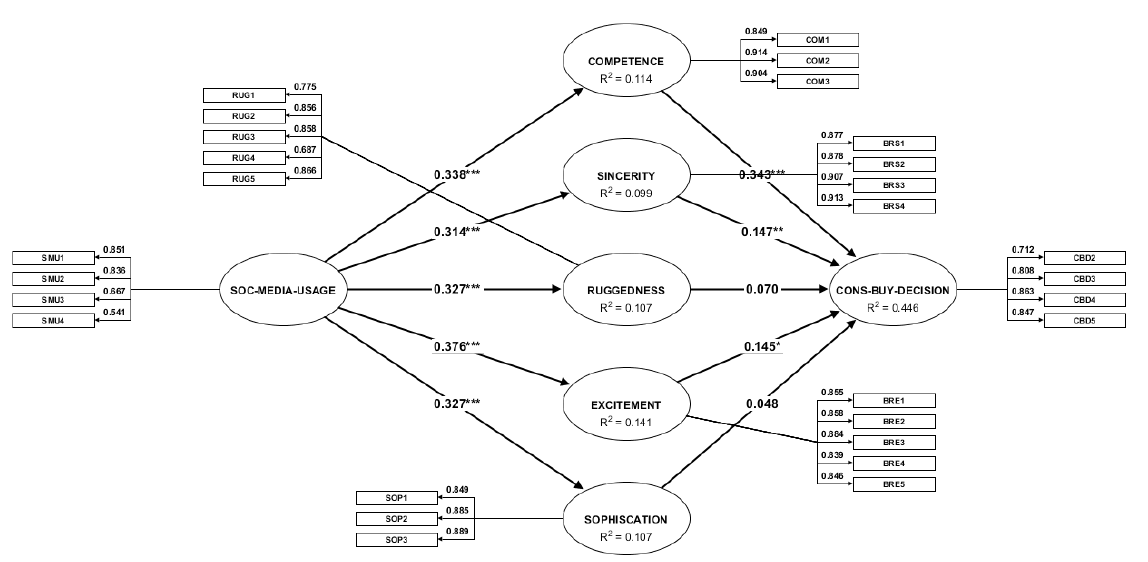
Figure 2. Estimated research